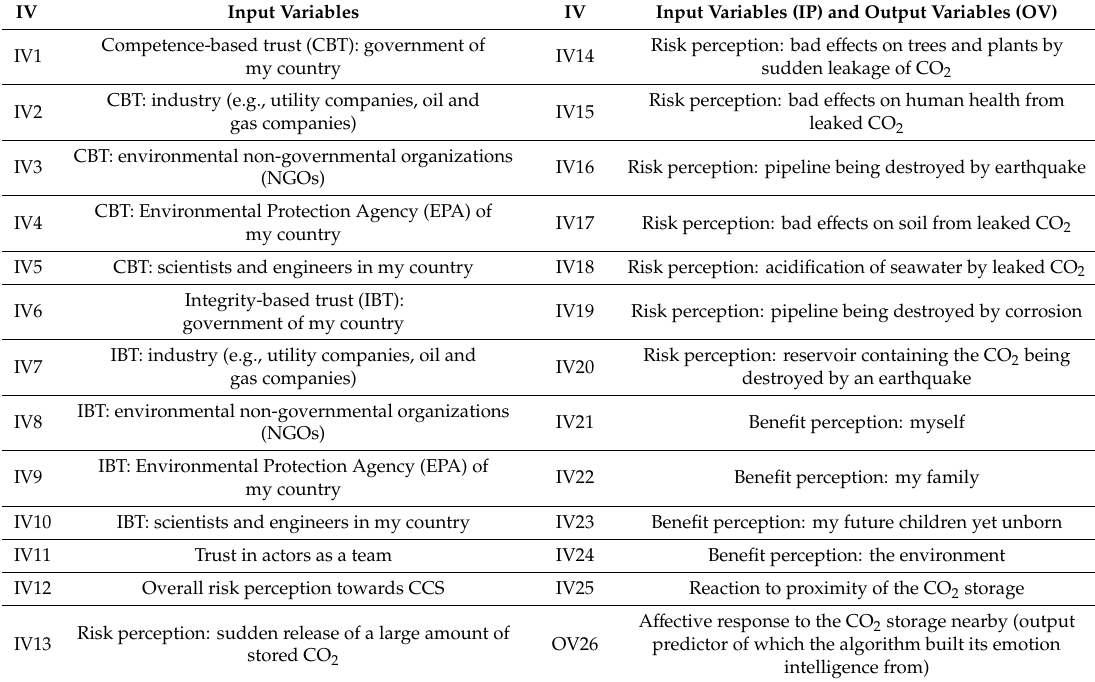
Table 2. Predictors used in the simulation experiment to predict the emotional response to the CO 2 storage nearby.